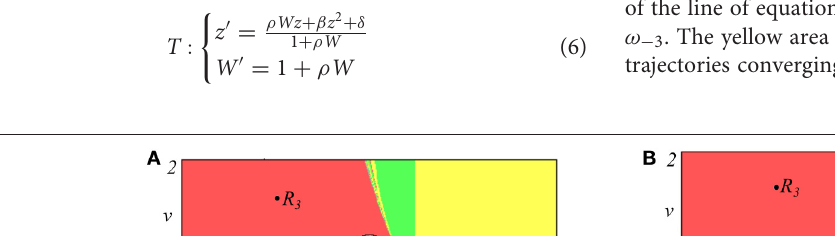
3 . The yellow area represents the set of points that generates − trajectories converging to the fixed point while the gray-shaded